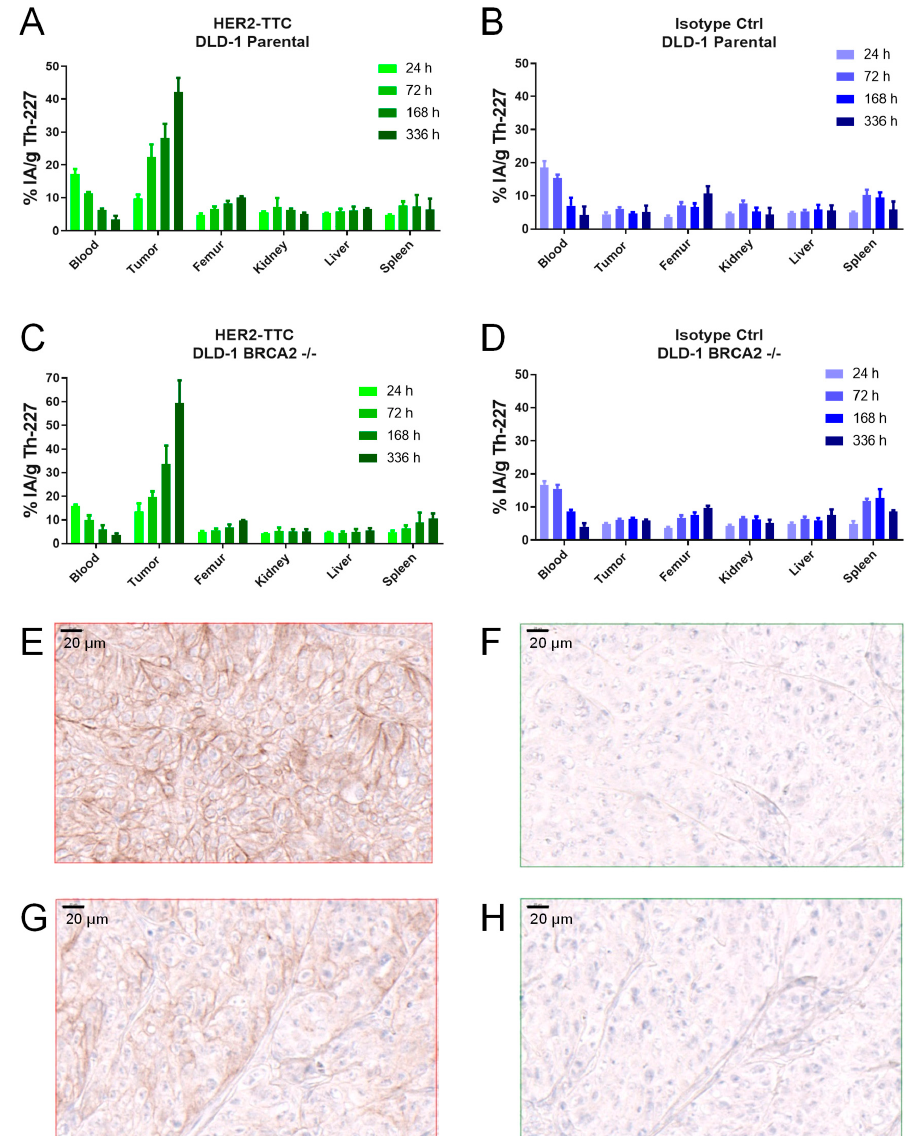
Figure 3. Biodistribution of HER2-TTC and a radiolabeled isotype control in mice with DLD-1 parental and DLD-1 BRCA2- / - xenograft model. ( A ) and ( C ) HER2-TTC and ( B ) and ( D ) radiolabeled isotype control 24, 72, 168, and 336 h after single intravenous dose administration (600 kBq / kg bw, 0.14 mg / kg bw, i.v.). For each time point organs from three individual animals were harvested. Thorium-227 activities were determined using a high purity germanium detector (HPGe) and expressed as percentage of the injected thorium-227 dose per gram. ( E ) HER2 IHC in DLD-1 parental tumors and ( F ) staining with respective isotype control antibody. ( G ) HER2 IHC in DLD-1 BRCA2 - / - tumors and ( H ) staining with respective isotype control